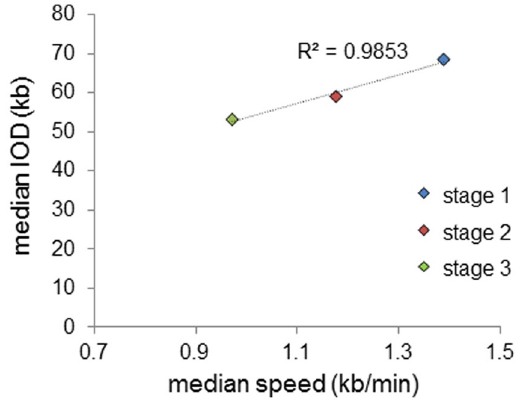
Figure 3. Inter-origin distances and fork velocities are positively correlated. Positive correlation between median inter-origin distances (IODs) and fork velocities in synchronous blood-stage parasites. Coefficient of determination (R 2 ) is